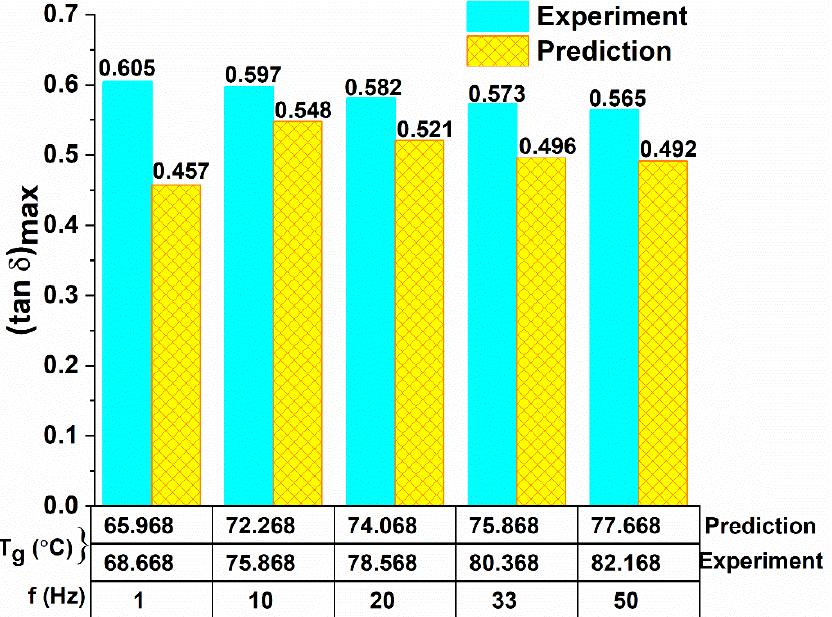
Figure 13. Comparison of predicted loss tangent and its T g values with experimental results for different frequencies of epoxy.